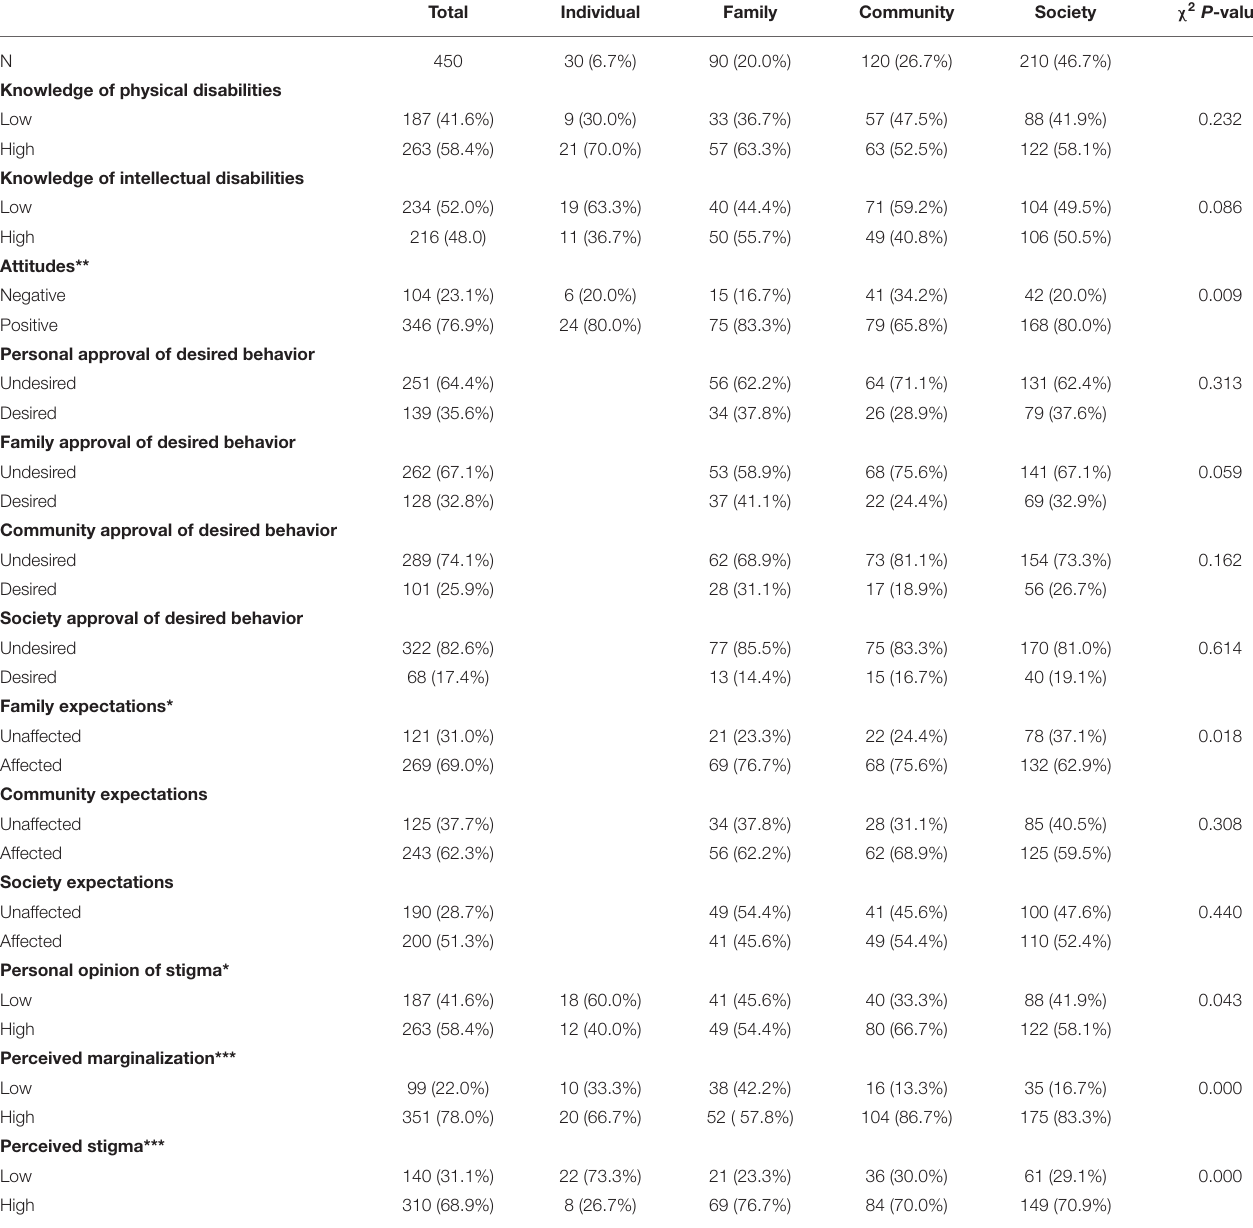
TABLE 3 | Frequency results for all constructs in the conceptual model, by total and by social ecological model level. Total Individual Family Community Society χ 2 P